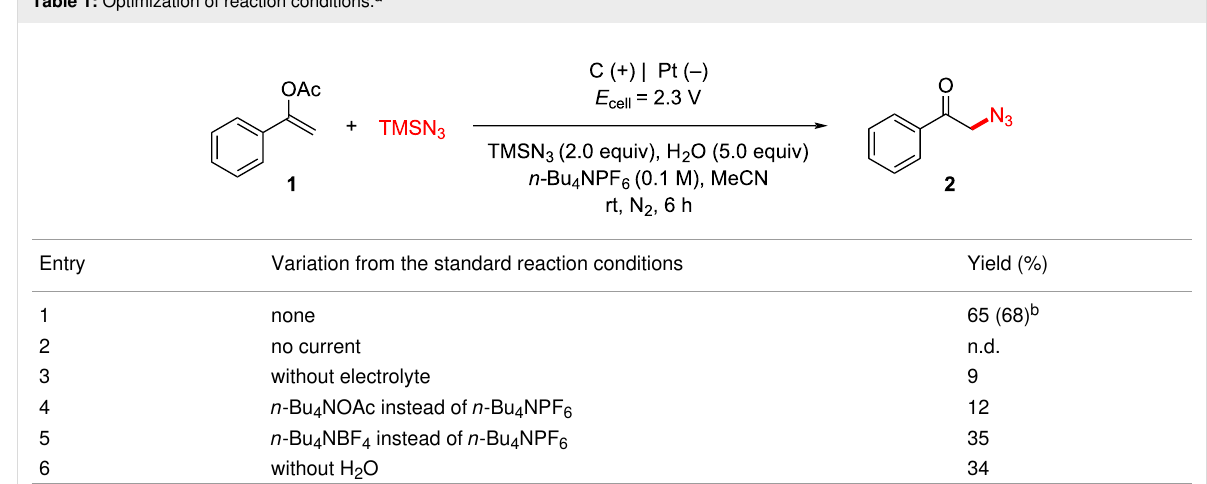
Table 1: Optimization of reaction conditions. a